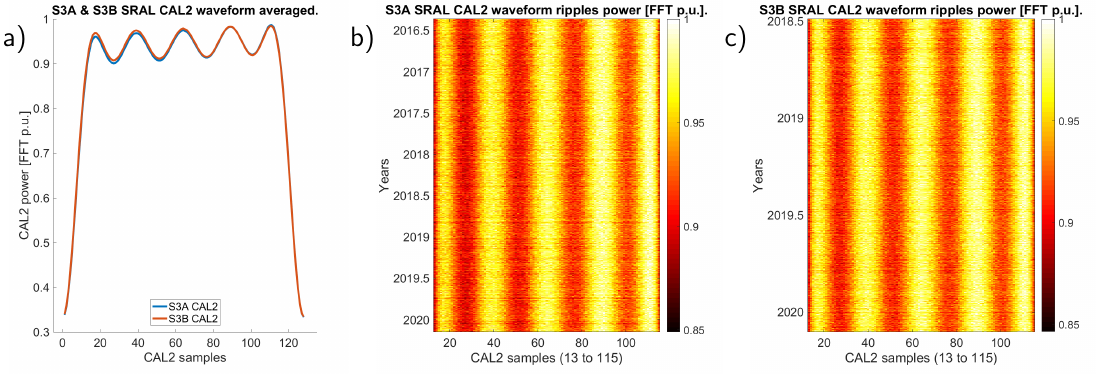
Figure 7. CAL2 correction (in FFT power units) of S3A and S3B missions: ( a ) averaged mission Transfer Function, ( b ) S3A CAL2 ripples progression, and ( c ) S3B CAL2 ripples progression.